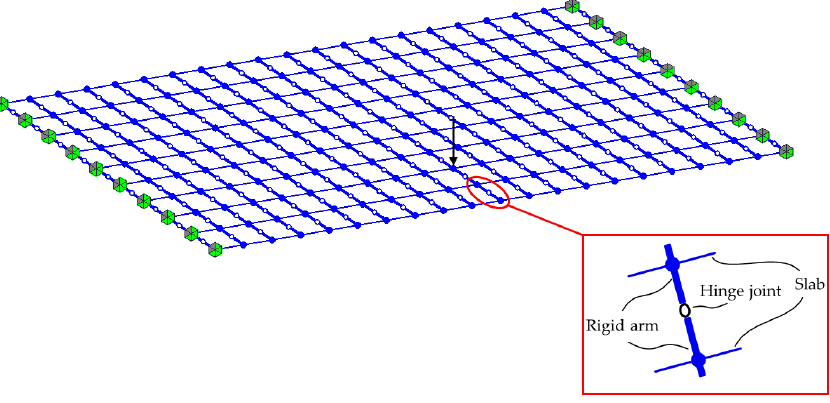
Figure 9. The finite element model and connection configuration.